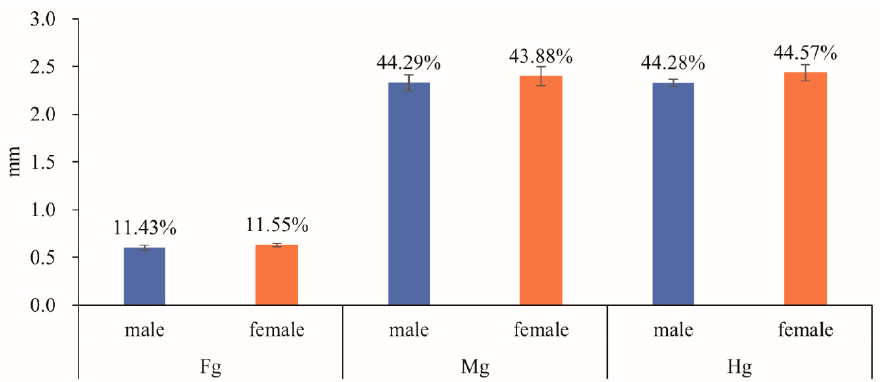
Figure 2. Relative proportions (mean ± SE) of three regions (Fg: foregut, Mg: midgut, Hg: hindgut) of the alimentary canal of male and female M . ( O .) chinensis ( n = 10). The y-axis (mm) indicates the actual length of each part of the alimentary canal; the numbers on the bar chart represent the per- centage of each part of the alimentary canal.